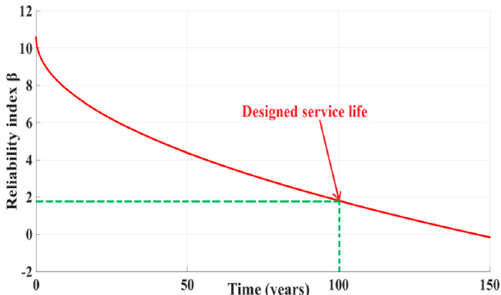
Figure 15. Reliability index calculated by the Monte-Carlo simulation for the box girder concrete.